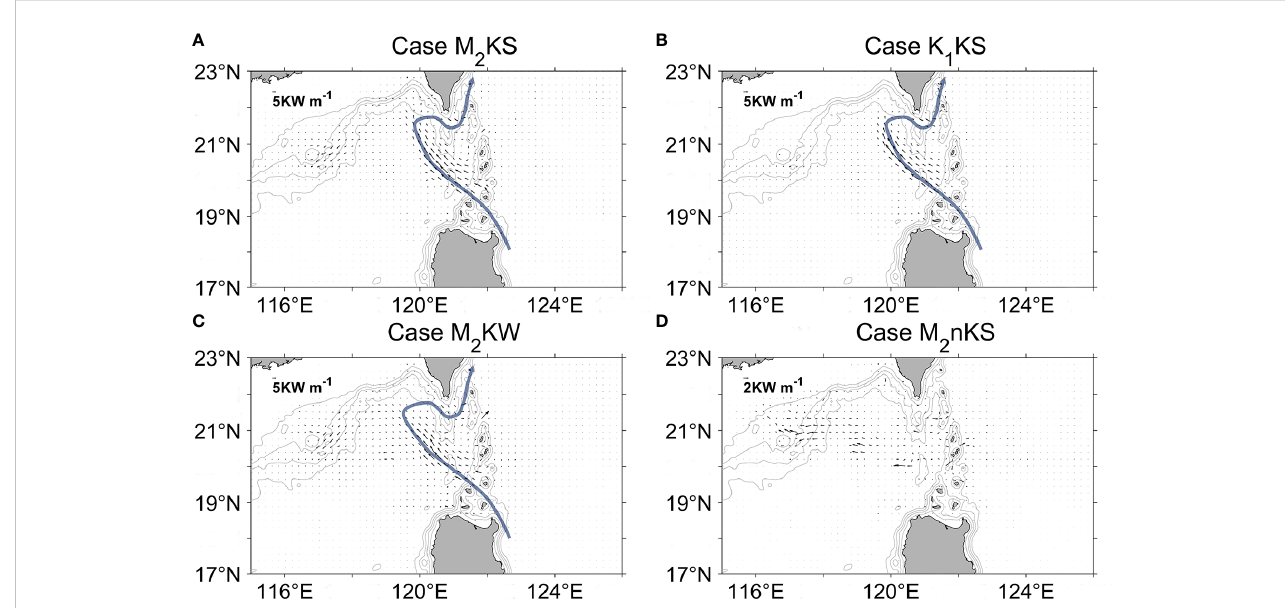
FIGURE 10 Spatial distribution of F nonbc (vectors) in the LS for four cases. (A) M 2 KS (summer, with-Kuroshio). Gray contours indicate isobaths. The curved path represents the Kuroshio path. (B) K 1 KS (summer, with-Kuroshio). (C) M 2 KW (winter, with-Kuroshio). (D) M 2 nKS (summer,